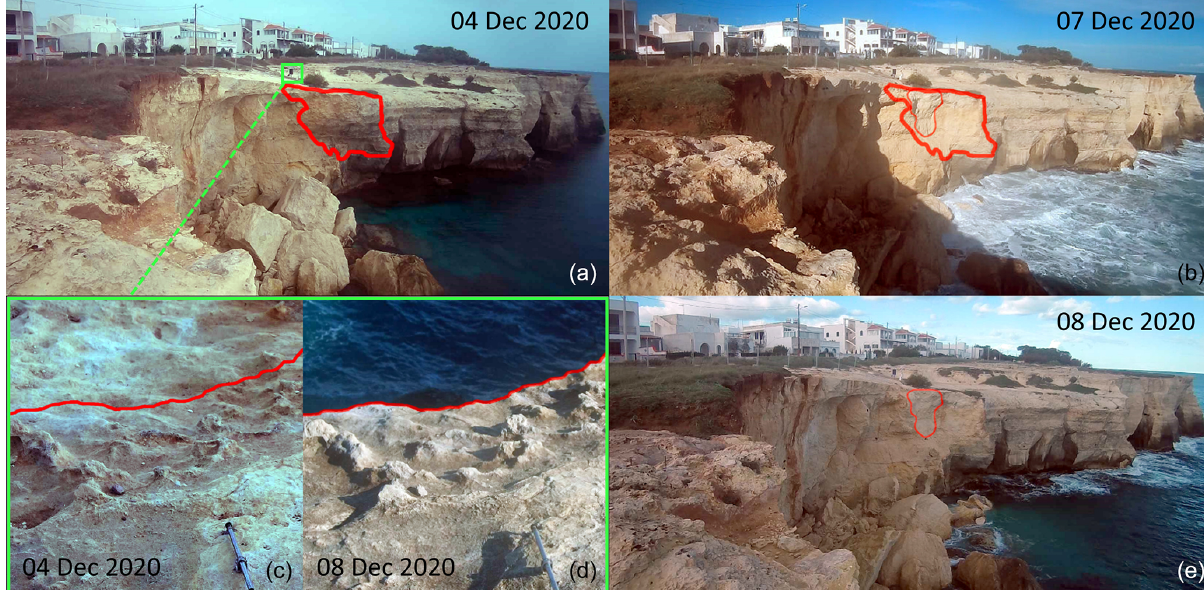
Figure 3. The second rockfall (marked with “B” in Fig. 1) – panel (a) shows the cliff as it was on 4 December 2020 and panel (b) shows it as it was on the morning of 7 December 2020, after the main collapse (marked by the thick red line). Panel (e) shows the cliff as it was on 8 December 2020, after a minor rockfall (marked by the thin red line). Those three images are taken from the secondary camera (see Fig. 1 for the position). In panels (c) and (d) , two smaller images that show the collapse from another point of view (the main camera, which could also be seen in the top left image, highlighted in green – see Fig. 1 for the position) both before the rockfall (c) and after it (d) . In those images, the newly installed automatic crack meter is also